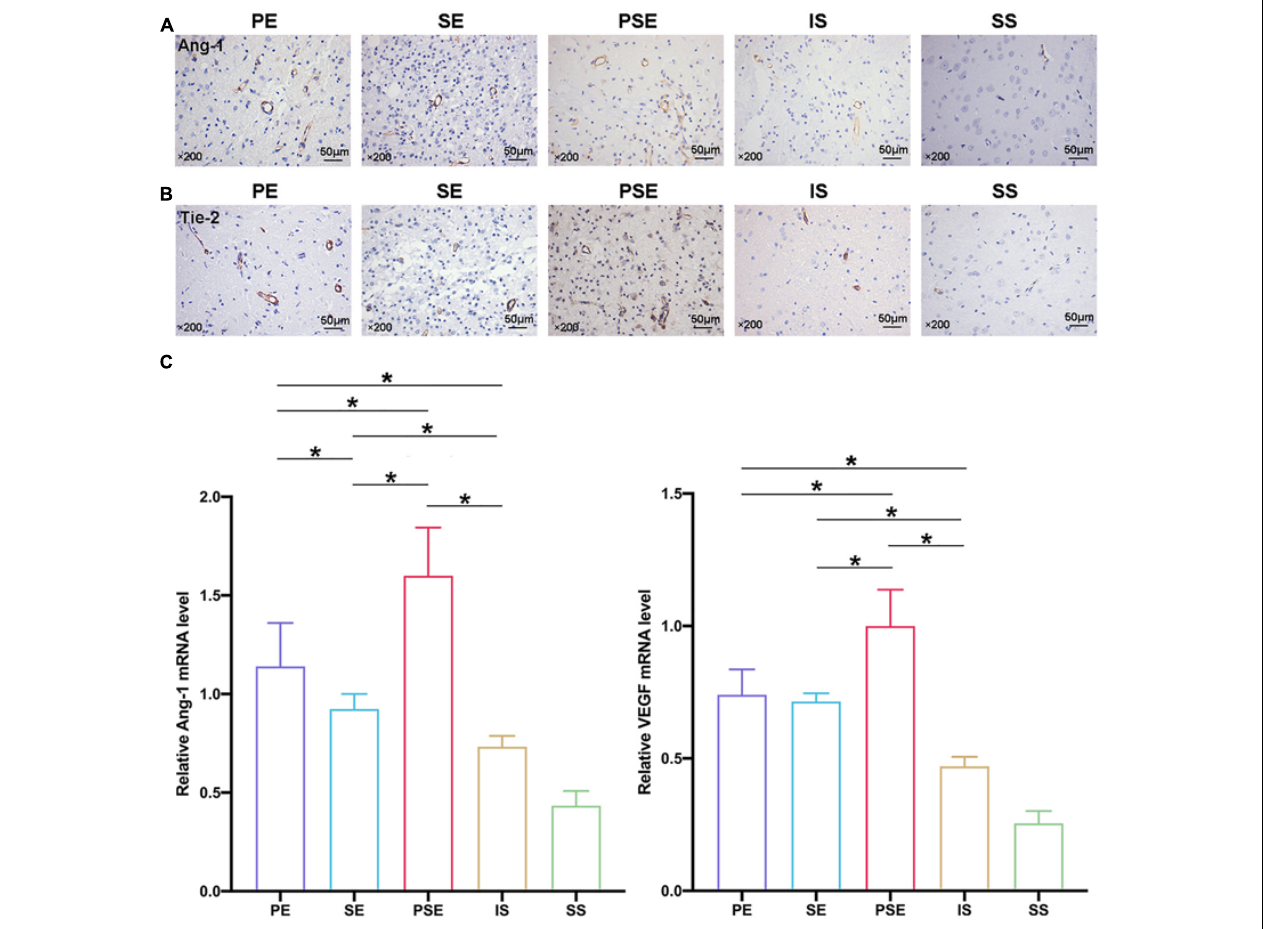
FIGURE 5 | Angiogenic factors expression in the penumbra at 14 days after ischemia/reperfusion. (A) Representative magnification images of Ang-1 immunohistochemical staining of five groups. (B) Representative images of Tie-2 immunohistochemical staining of five groups. (C) Quantitative analysis of relative VEGF/Ang-1 mRNA levels in five groups, while PE, SE, and PSE conditionings increased Ang-1 and VEGF mRNA levels compared to IS group. n = 6. Data are expressed as mean ± SEM; * P <